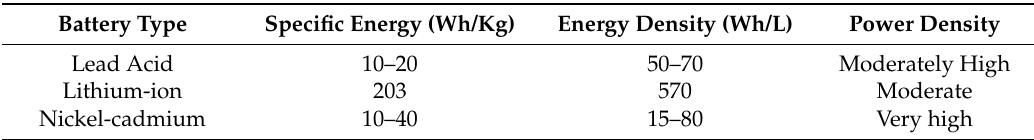
Table 1. Important characteristics of batteries well recognized for energy